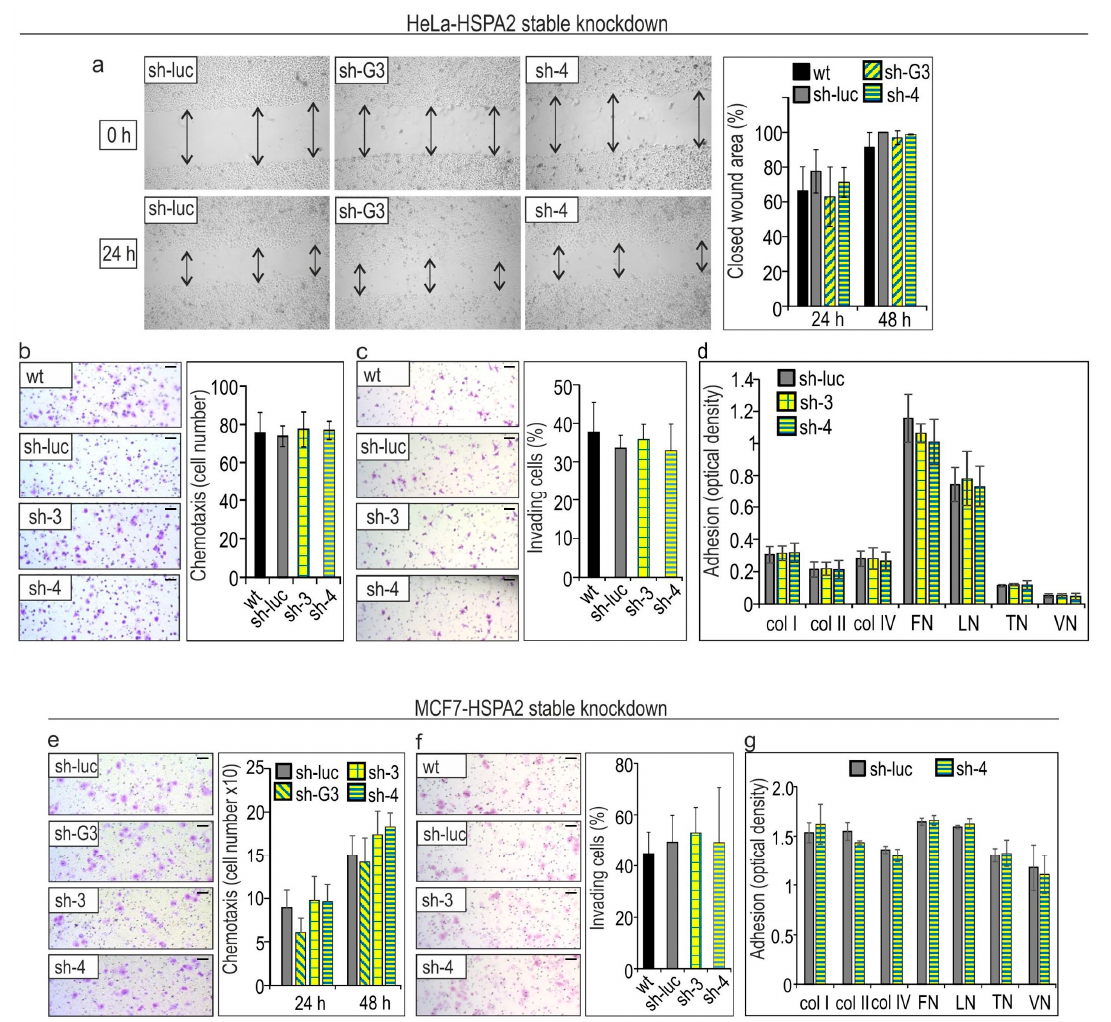
Figure 7. The motility, invasiveness, and adhesiveness of ( a – d ) HeLa and ( e – g ) MCF7 cells are not dependent on HSPA2 protein level. ( a ) Results of wound-healing assay. Representative microphotographs show the wound area immediately after making a scratch in confluent culture and also after 24 h culture. Arrows mark the width of wounds. The graphs show results (mean ± SD) of three independent experiments, each at least in ten technical replicas. ( b , e ) Results of a transwell migration assay. Cells (6 × 10 4 ( b ), 7 × 10 4 ( f )) were plated onto the insert and allowed to migrate for 4 h ( b ) or 24–48 h ( f ) toward the FBS gradient (1–10%). Representative microphotographs show crystal violet-stained cells that migrated through the membrane pores. Graph shows relative chemotactic migration (mean ± SD, n = 3, each in two technical repeats). ( c,f ) Analysis of cell invasion into Matrigel. Representative microphotographs show cells that migrated into the ECM matrix. The scale bar represents 50 µm. The graph shows the percentage of invading cells (mean ± SD, n = 4, each time cells were counted in 6–7 different areas). ( d,g ) Cells (7 × 10 4 /well) were plated onto ECM Cell Adhesion Array strips and allowed to attach for 1 h. After staining with crystal violet, optical density was measured. Results show mean ± SD ( n = 3).